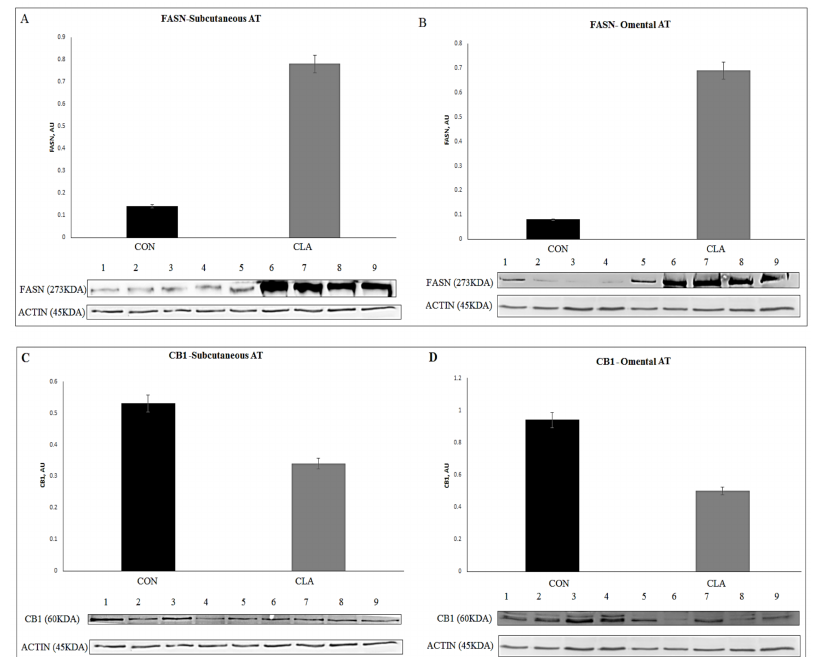
Figure 7. Immunoblot analysis of lipogenesis was measured by the abundance of FASN in CON vs. CLA ( n = 1–4 replicates for CON; n = 5–9 replicates for CLA). ( A ) Abundance levels of FASN in subcutaneous (SC); ( B ) abundance levels of FASN in omental (OM) AT in CLA and CON. Immunoblot analysis of the endocannabinoid receptor CB1 abundance in CON vs. CLA ( n = 1–4 replicates for CON; n = 5–9 replicates for CLA). ( C ) Abundance of CB1 in subcutaneous (SC); ( D ) omental (OM) AT CLA and CON. Actin was used as a control to quantify the